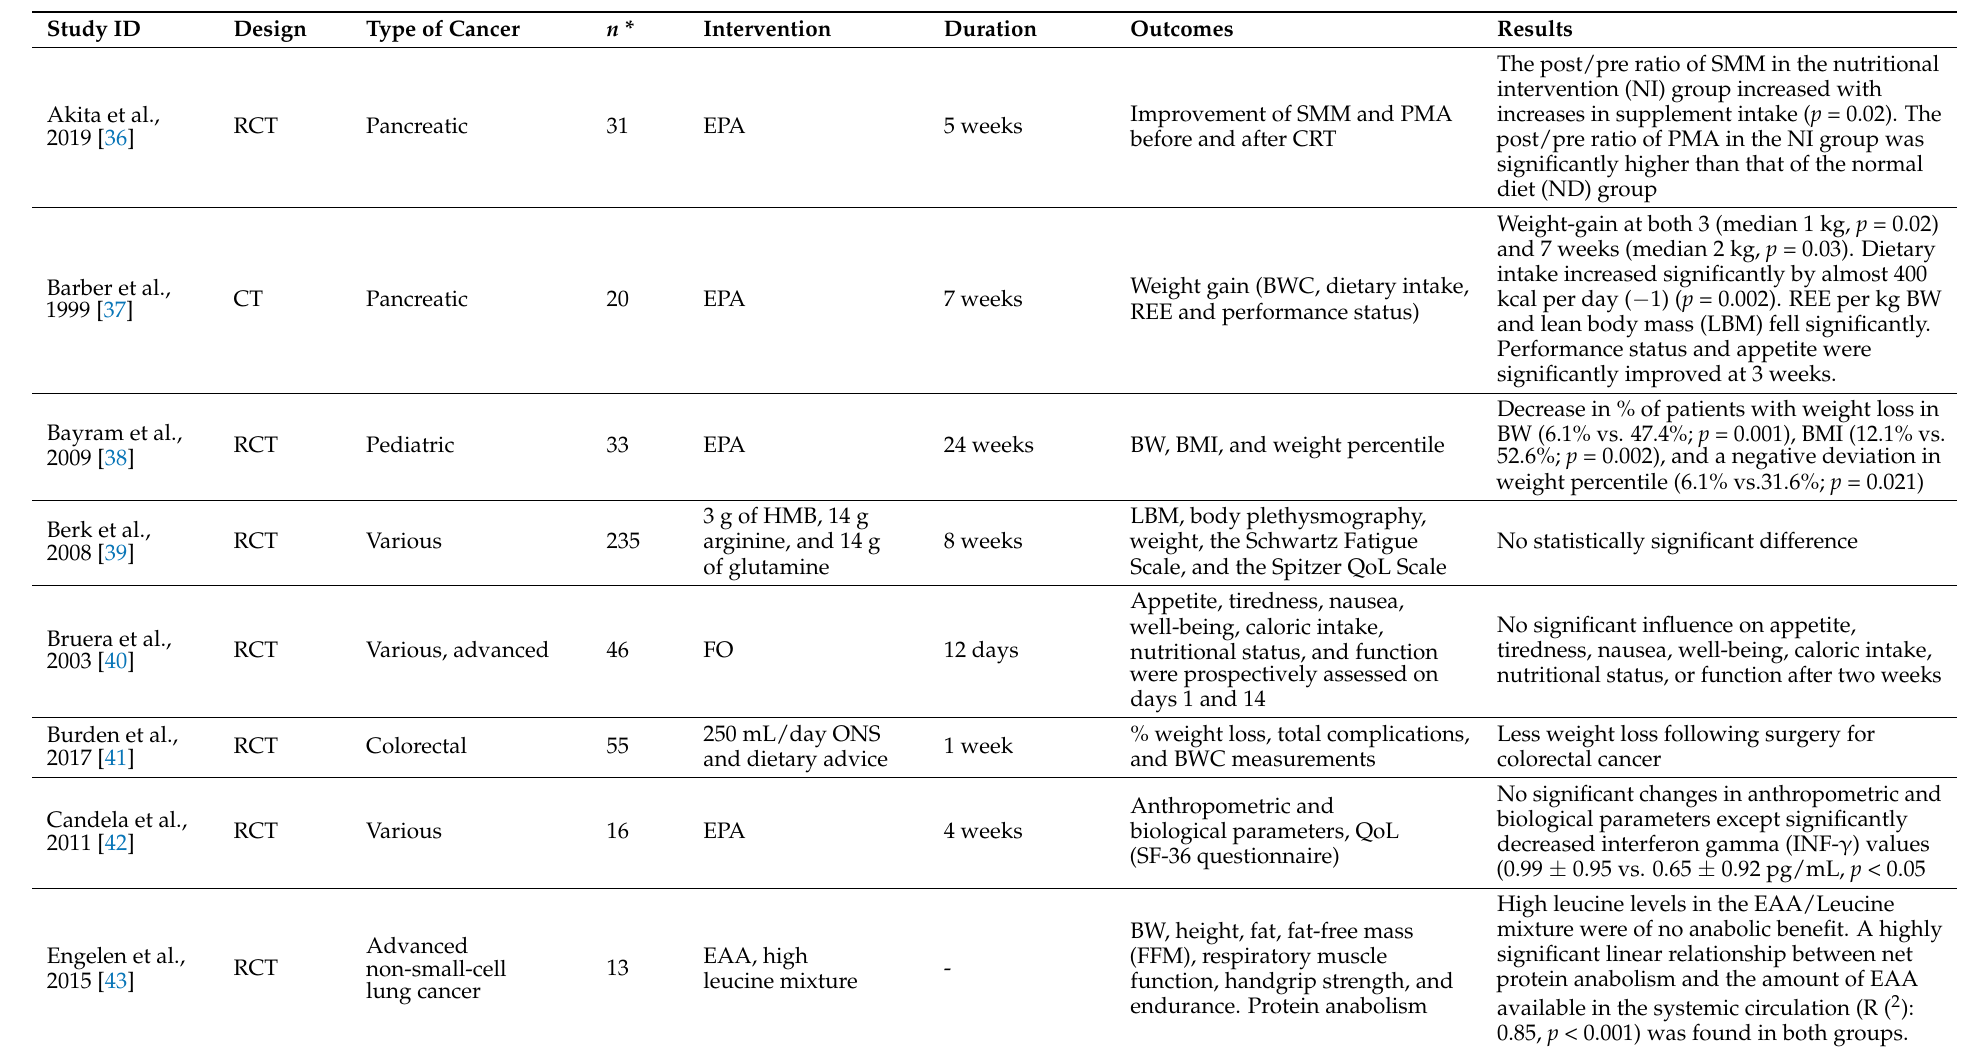
Table 1. The characteristics of the studies included in the